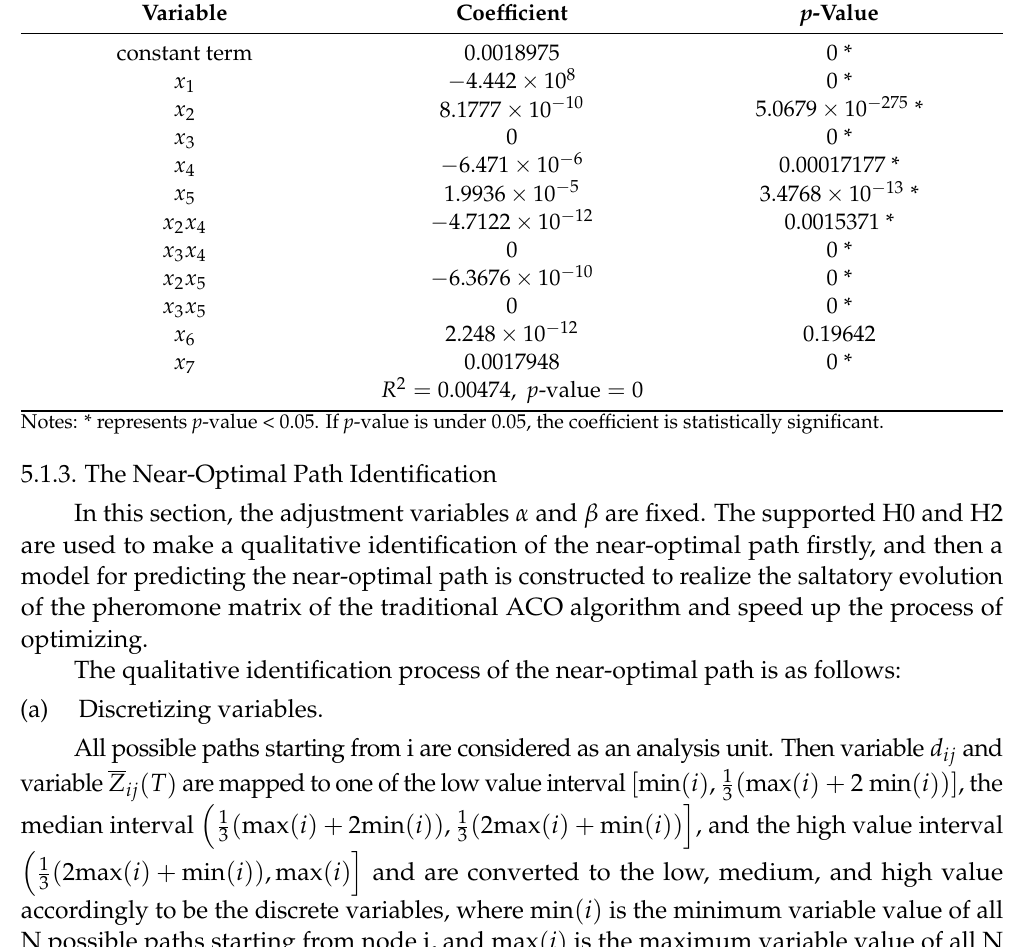
Table 1. The results of quantitative analysis model test. Variable Coefficient p -Value constant term 0.0018975 0 * x 1 − 4.442 × 10